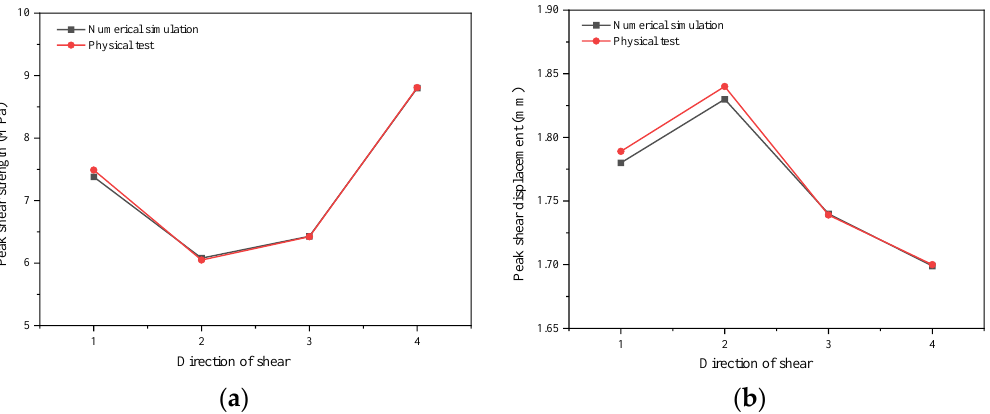
Figure 12. Comparison between peak parameters of the four groups of model samples and physical test results: ( a ) peak shear strength; ( b ) peak shear displacement.